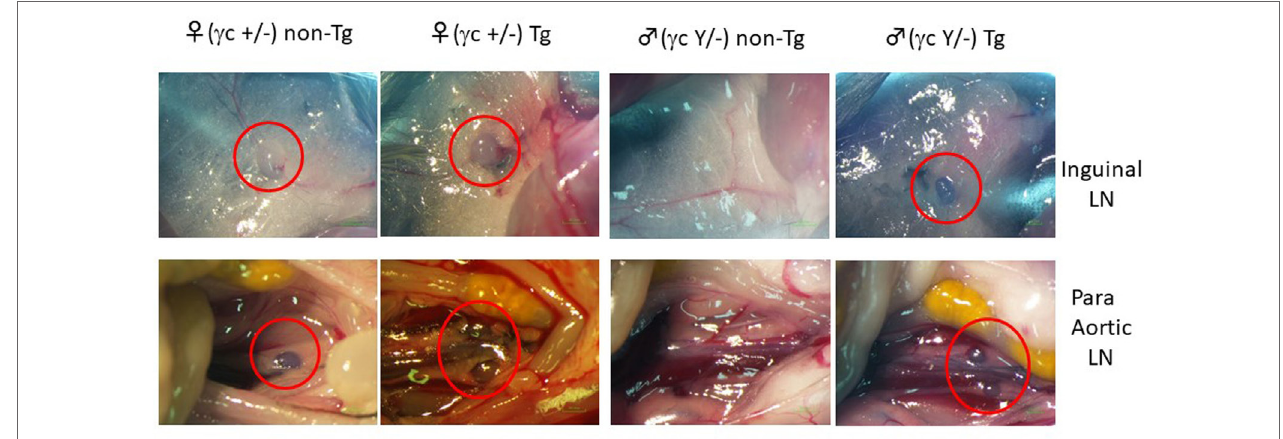
FigUre 1 | Induction of lymph node (LN) organogenesis in γ c-deficient mice using the pROR γ t- γ c transgene. A bacterial artificial chromosome (BAC)-transgenic (Tg) male founder mouse was crossed with female NOD/shi- scid -IL-2R γ null (NOG) mice. The presence of LNs in the F1 mice was macroscopically confirmed. Red circles indicate inguinal LNs (top panels) and para-aortic LNs in the abdomen (bottom panels). FigUre 2 | Restored lymph nodes (LNs) in NOG mice. (a) LNs in NOG-pROR γ t- γ c Tg and NOG non-Tg mice. Evans Blue was subcutaneously administered into the tail base or foot pad for visualization of draining LNs (left panels). Red circles indicate inguinal, axillary/brachial, and popliteal LNs. Representative mesenteric LNs (mLNs) from NOG-pROR γ t- γ c Tg and NOG non-Tg mice are shown in the right panel. Two distinct LNs from NOG mice are circled in red. (B) Efficiency of LN restoration in NOG–pROR γ t- γ c Tg mice. NOG-pROR γ t- γ c Tg or NOG non-Tg mice were examined for the presence of tissue-associated LNs. For scoring, the number of LNs in each tissue from individual mice was counted and the ratio to the number of the corresponding tissue-associated LNs in wild-type NOD mice was calculated. Mean ± SD from NOG-pROR γ t- γ c Tg ( n = 9) and NOG non-Tg mice ( n = 15). Student’s t -test was performed to assess statistical significance (* p < 0.05 and ** p < 0.01).